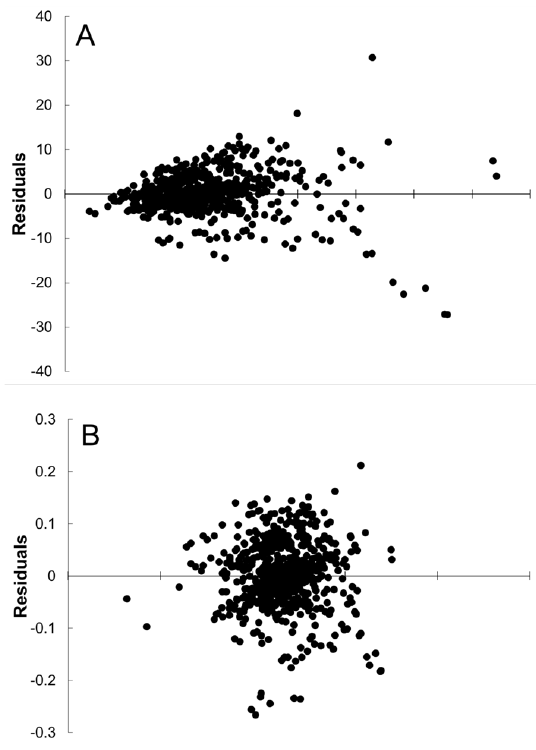
Fig. 3. Residual plots for 714 observations of C d and B d from liter- ature review and field samples. (A) Residuals of original data in- dicating increasing variation in C d with increasing bulk density. (B) Residuals of log transformed